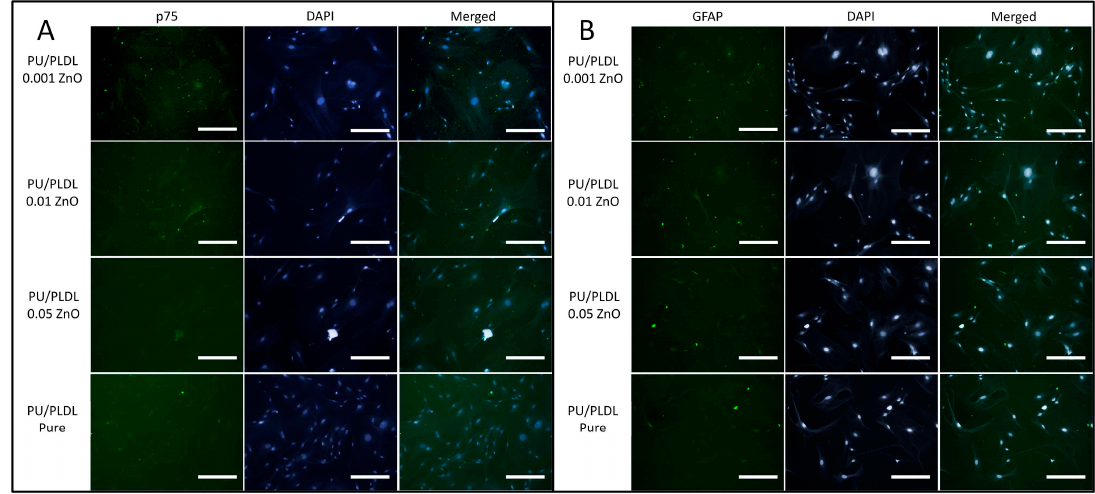
Figure 7. The immunofluorescent staining of olfactory ensheathing cells for specific p75 ( A ) and GFAP ( B ) proteins, combined with nuclei staining (DAPI), magnification 400×, scale bar = 20 µm.